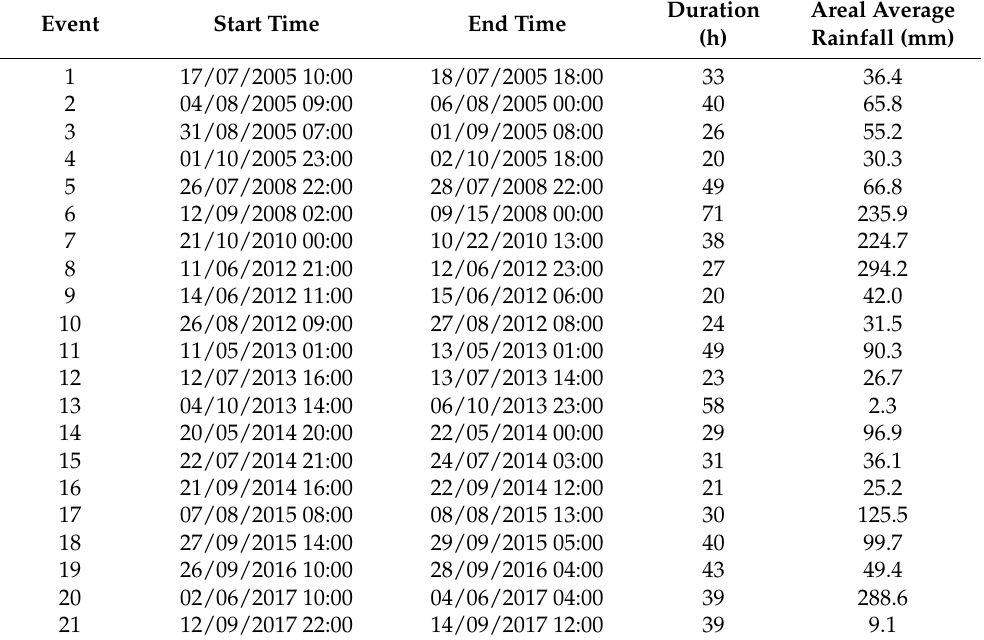
Table 1. Actual rainfall events used for increasing the number of rainfall events.